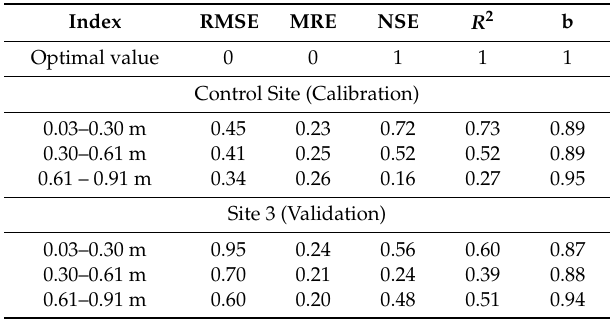
Table 8. Statistical indices for simulated vs. observed soil water EC (EC sw ).